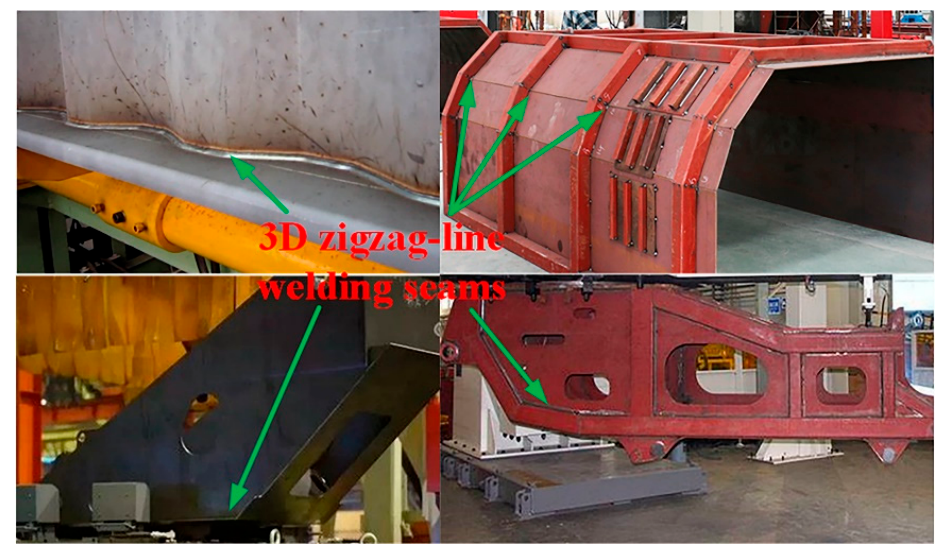
Figure 1. Examples of three-dimensional (3D) zigzag-line welding seams.